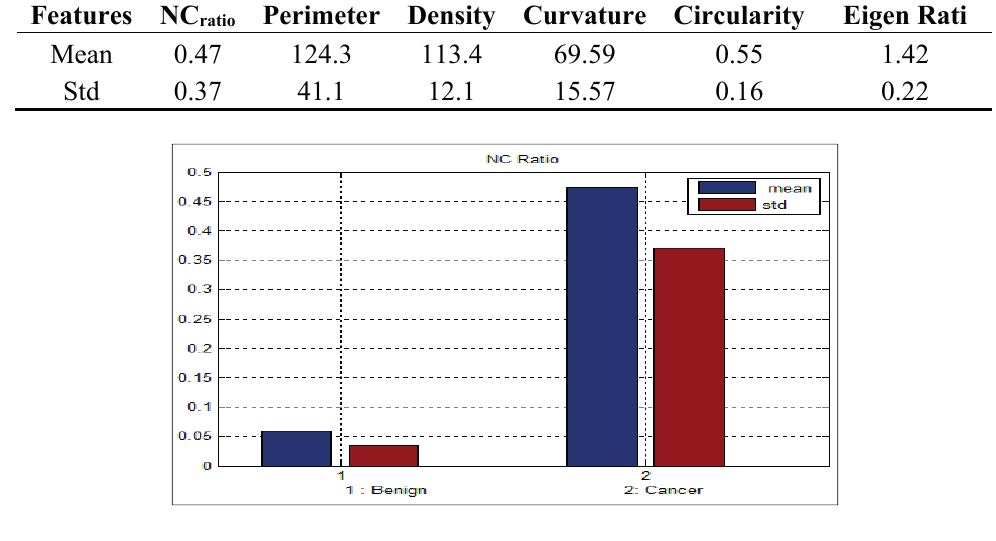
Figure 9. Mean and standard deviation for the NC ratio.